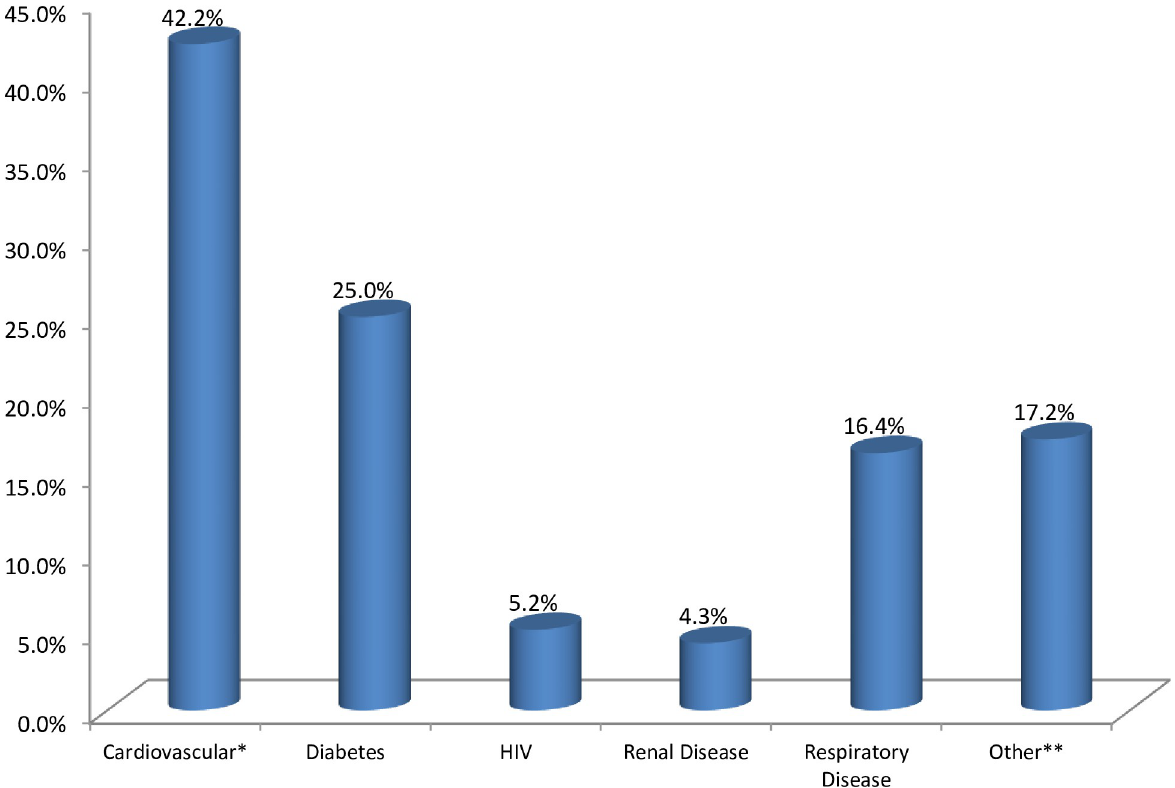
Fig 2. Types of underline comorbidity COVID-19 patients inTigray, Ethiopia, 2020. � Cardiovascular disease included hypertension and heart failure. �� Other: Traumatic injury, gastritis, pregnancy, allergic, psytotic disorder, rabies, arthritis, epilepsy, neurological.